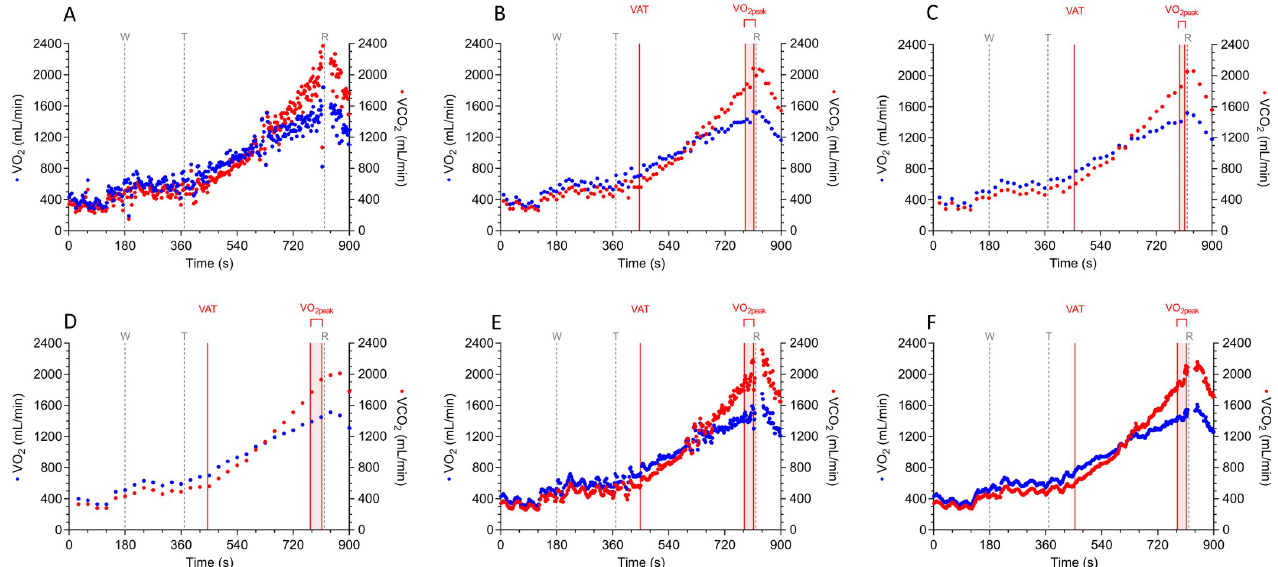
Fig 1. Visualization of the plot with oxygen uptake (VO 2 ) and carbon dioxide production (VCO 2 ) over time without data-averaging (graph A) and using the five different data-averaging intervals: a stationary time-based average of 10 seconds (graph B), 20 seconds (graph C), and 30 seconds (graph D), a rolling average interval of 3 breaths (graph E) and 7 breaths (graph F) in patient 21. See S1 File for a graphical display of the Wasserman plots of patient 21 with the different data-averaging intervals. Note that the number of data points is lower when stationary time-based averaging is used (and decreasing with longer data- averaging intervals) compared to when a rolling average is used. In addition, a lower number of data points leads to smoothing of the VO 2 and VCO 2 curves. Abbreviations: VAT = ventilatory anearobic threshold; VCO 2 = carbon dioxide production; VO 2 = oxygen uptake; VO 2peak = oxygen uptake at peak exercise. Vertical grey dotted lines represent start of the warm-up phase (W), test phase (T), and recovery phase (R).